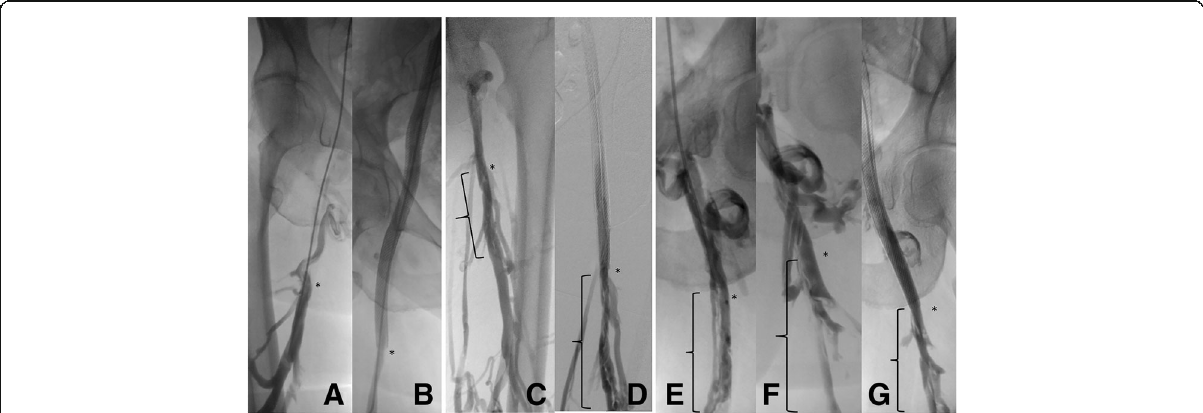
Fig. 3 Examples of classification of deep femoral vein inflow. 0 a , b Good inflow with a grade 3 axial transformation. c , d Fair inflow with a grade 3 axial transformation and post-thrombotic obstruction caudal to lower stent border. 0 e , f , g Poor inflow with grade 2 axial transformation and post-thrombotic obstruction of both the femoral and deep femoral vein caudal to lower stent border. 0 a , b and e , f , g With contrast injection into the deep femoral vein and no opacification of the femoral vein. * indicates the level of the lower stent border in the deep femoral vein. {indicates post-thrombotic segment caudal to lower stent